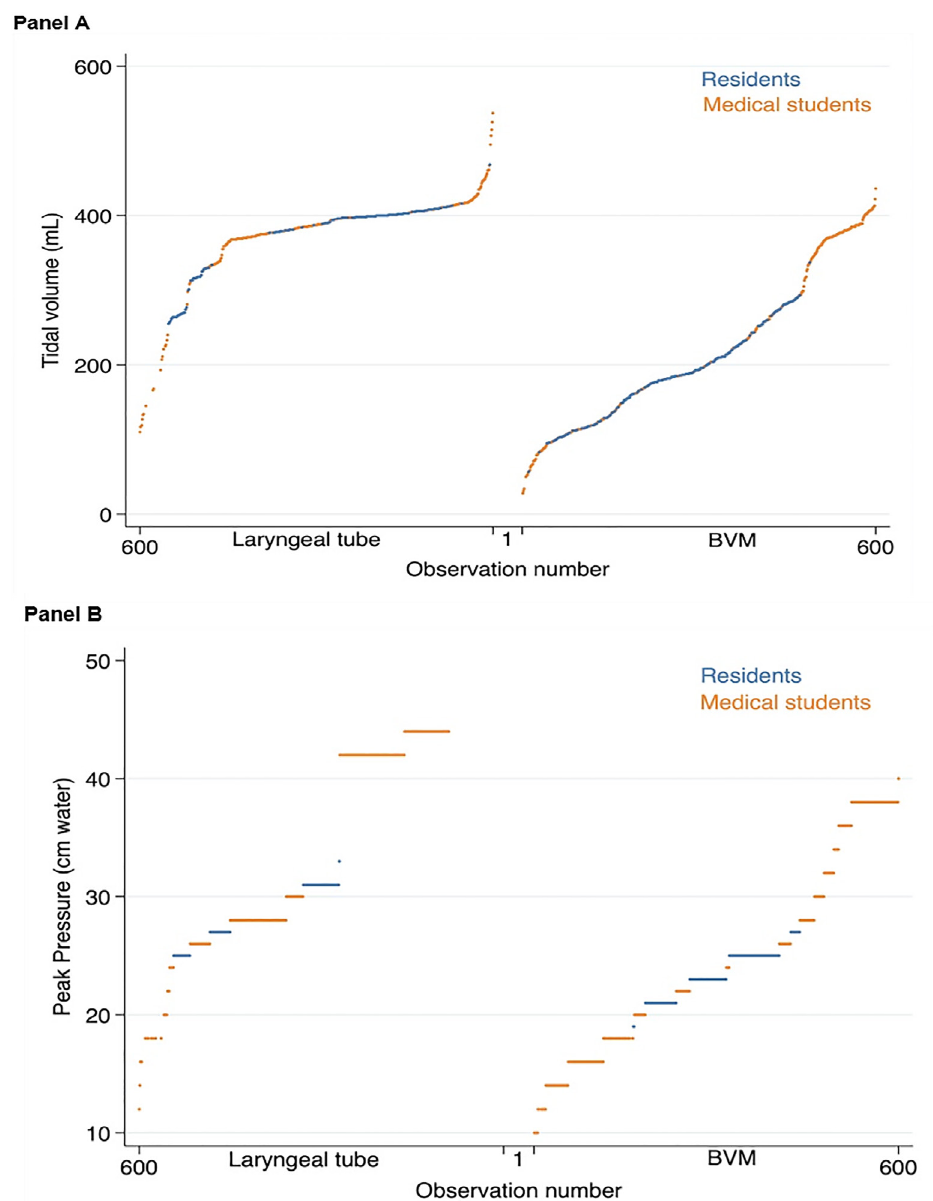
Figure 1. Tidal volume and peak pressure. This figure displays each tidal volume (panel A) and peak pressure (panel B) measurement for the 1,200 breaths administered, sorted in ascending order and by group. mL , milliliters; cm , centimeters; BVM , bag mask